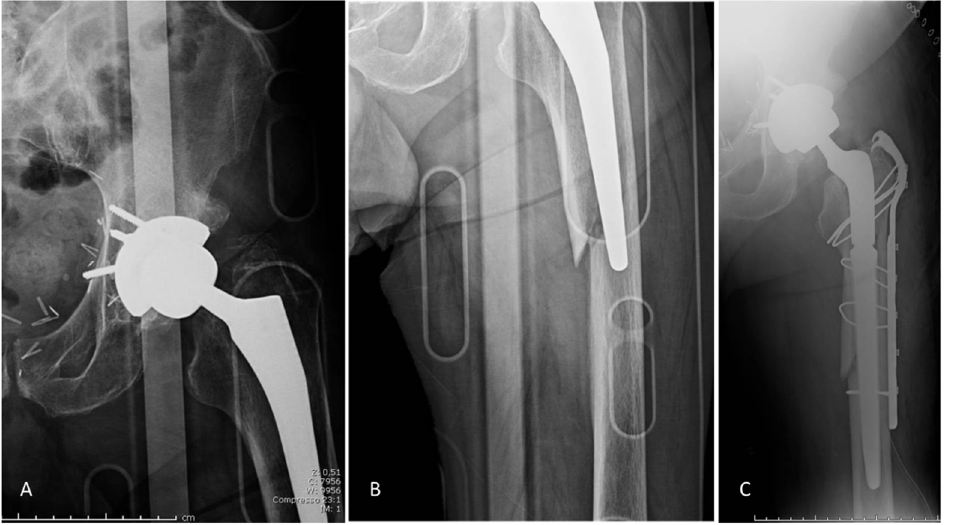
Figure 3. ( A , B ) Postoperative B2 periprosthetic fracture after trauma, which was successfully treated with stem revision with an uncemented, long modular revision stem and osteosynthesis by cerclage and fixation plate ( C